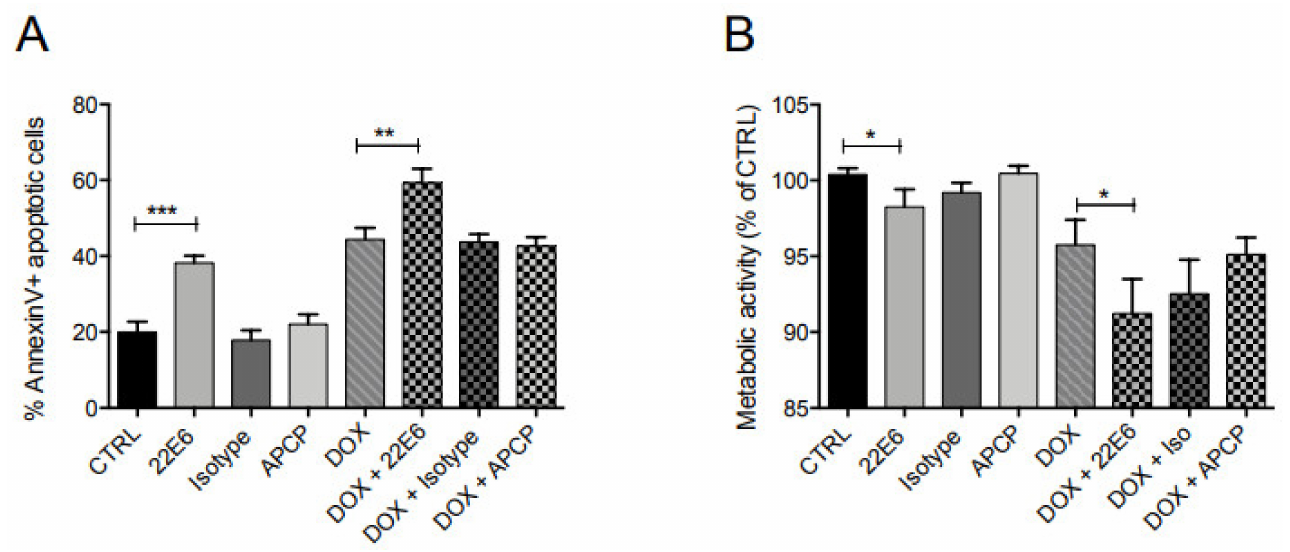
Figure 6. 22E6 induces statistically significant apoptosis in triple-negative breast cancer cells. ( A ) 22E6 induces apoptosis in MDA-MB231 TNBC cells alone and in combination with DOX as measured in an Annexin V assay. ( B ) A TMRE assay revealed a reduction of mitochondrial activity in MDA-MB231 cells upon incubation with 22E6 alone or in combination with DOX. One representative experiment of three is shown. * p < 0.05; ** p < 0.01; *** p <